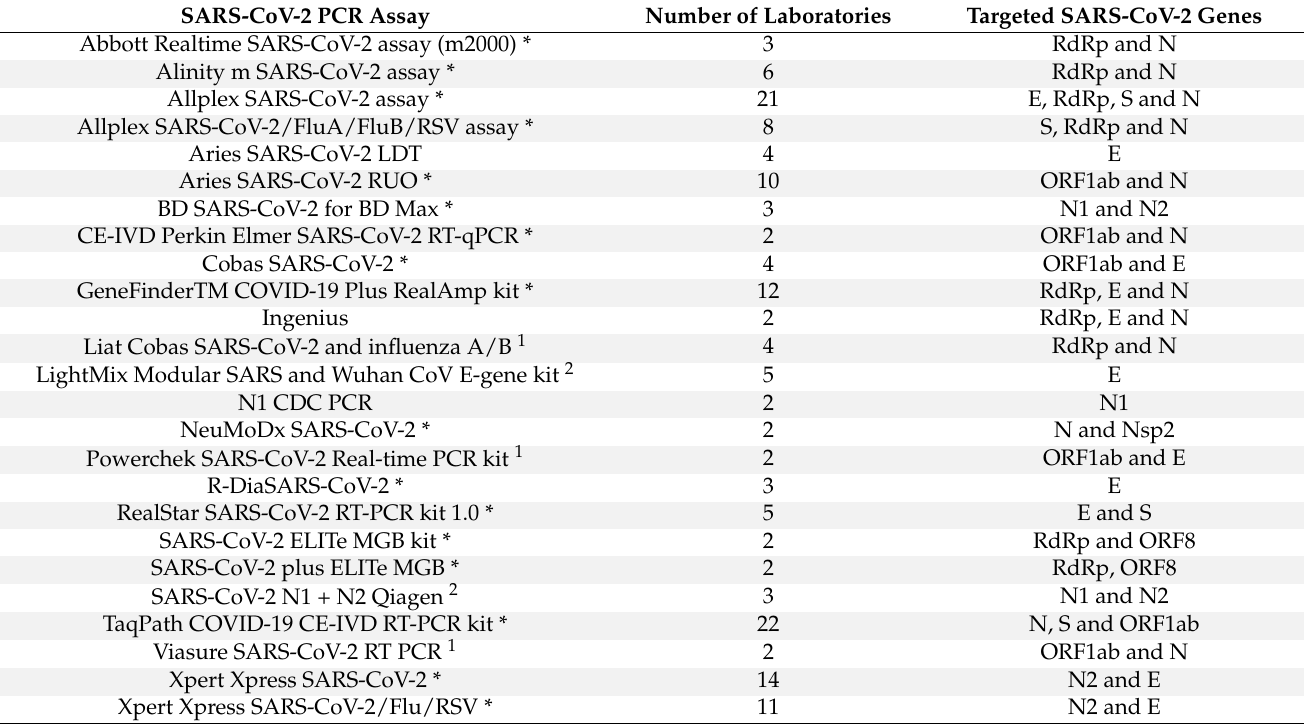
Table 2. Overview of PCR assays used by laboratories in Belgium that were declared to perform SARS-CoV-2 testing in a routine diagnostic setting. Only PCR assays for which the results of the setup standard curve were shared with the NRC, were considered. The number of laboratories that use each PCR assay is listed, as well as the targeted SARS-CoV-2 genes. The PCR assays are listed in alphabetical order.